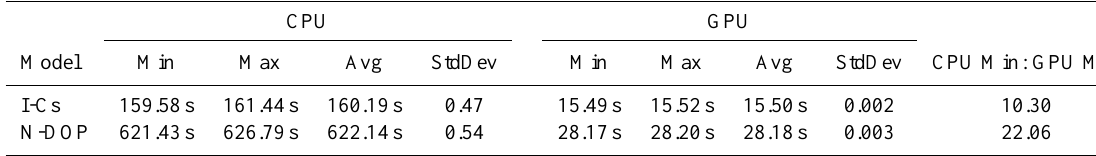
Table 4. The three main portions in every time step of the spin-up. Lines in Alg. 1 Routine Description 4 BGCStep Evaluation of source-minus-sink terms 5 MatCopy , MatScale , MatAXPY Interpolation of transport matrices 6, 7 MatMult Multiplication of transport matrices with tracer